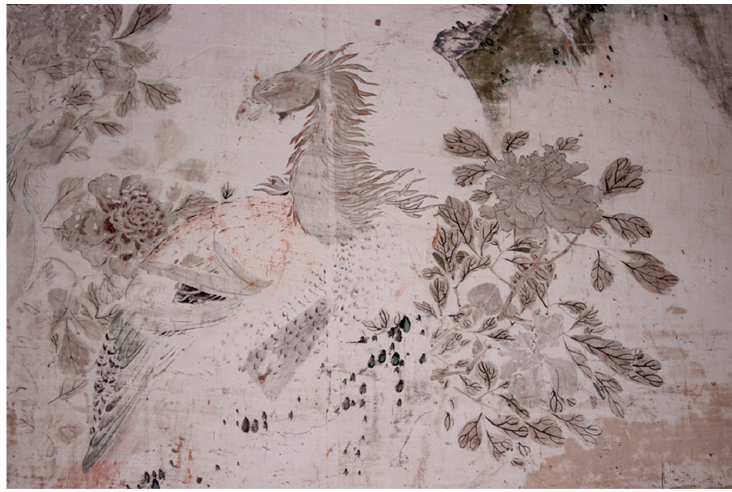
Figure 9. An ink-and-wash seated screen in the East Temple in the Dongjinzhai Village, Shimo Town (No. 36 in Figure